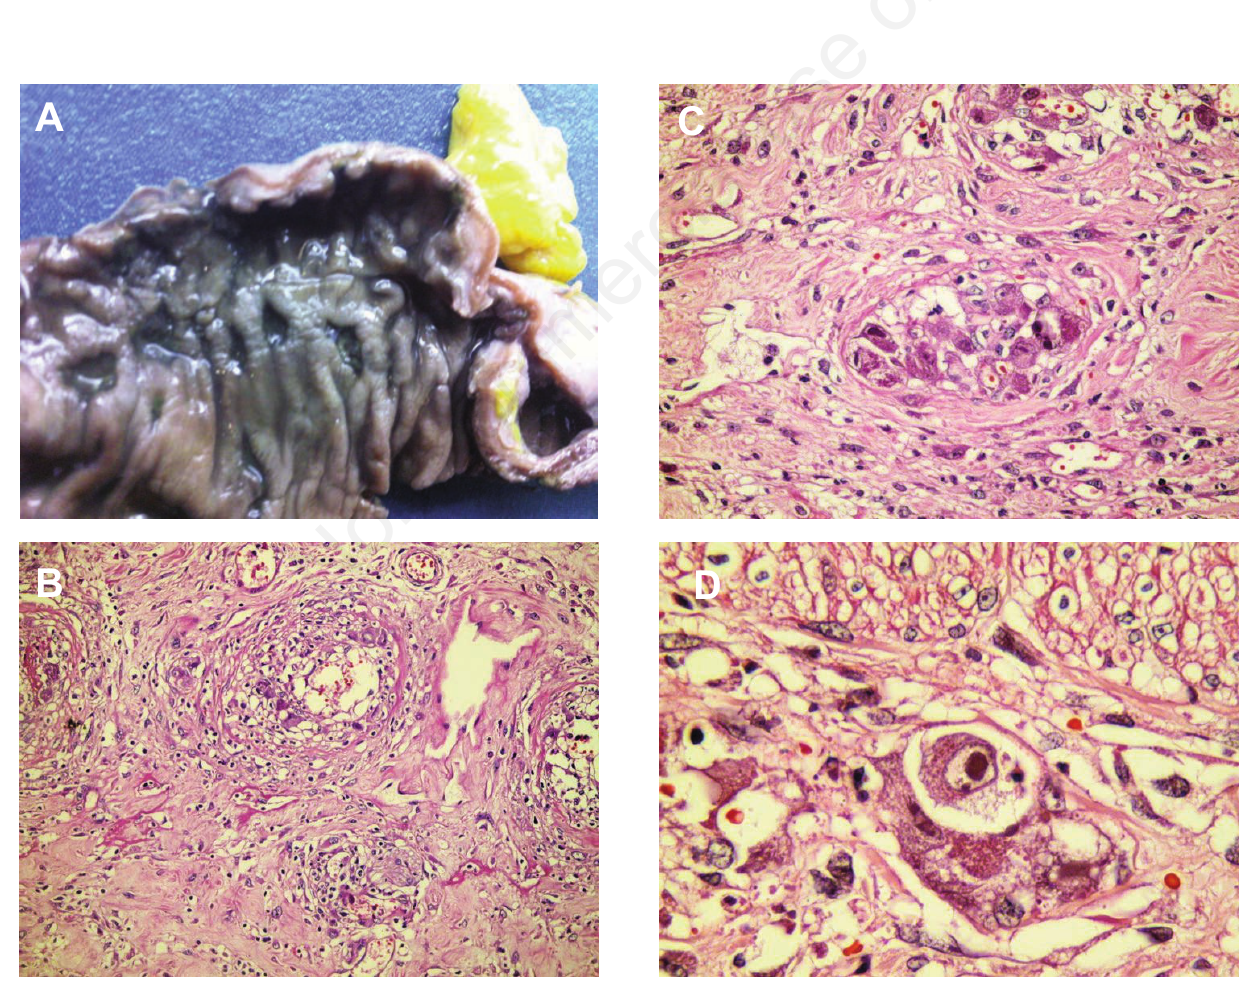
Figure 2. A) Colonic ulcer caused by cytomegalovirus with granulation tissue and necrosis at the base (Hematoxylin & Eosin, 50×). B) Typical nuclear inclusion within an endothelial cell and perineural stromal cells (Hematoxylin & Eosin, 200×). C) Characteristic owl's-eye inclusions are seen in endothelial cells in the ulcer base (Hematoxylin & Eosin, 400×). D) Immunohistochemistry highlights many inclusions in the stroma of a large bowel (Immunperoksidase, CMV,